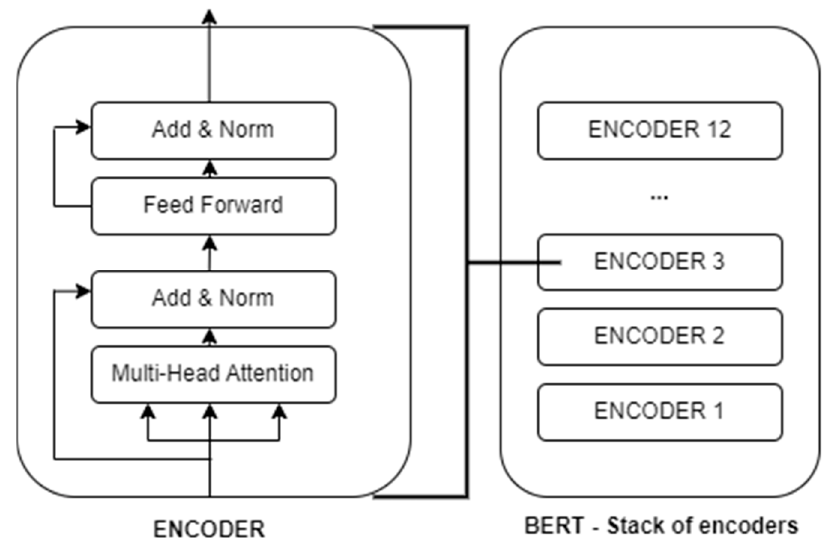
Figure 2. Network architecture, BERT.